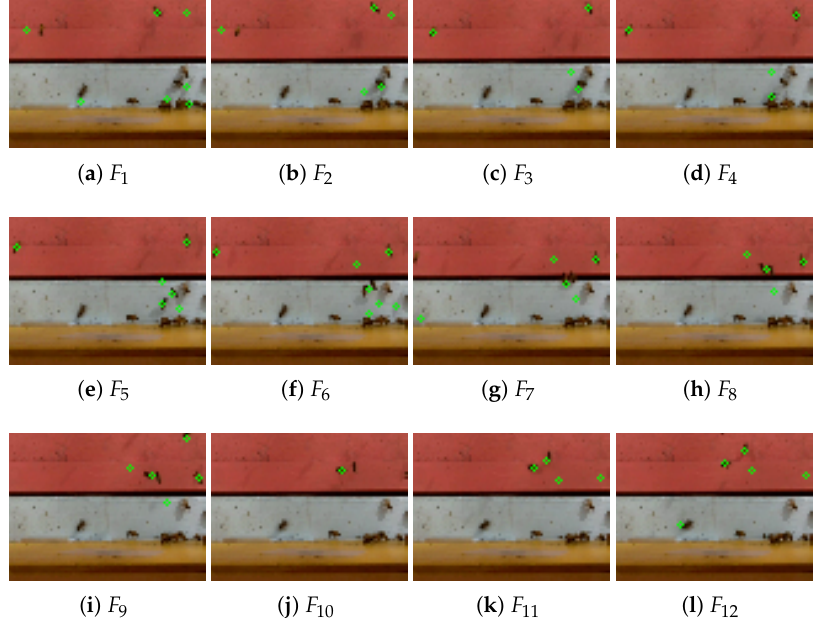
Figure 12. Motion points from motion frames W 1 to W 12 in Figure 11 plotted on original frames F 1 to F 12 in Figure 2 from which motion frames were